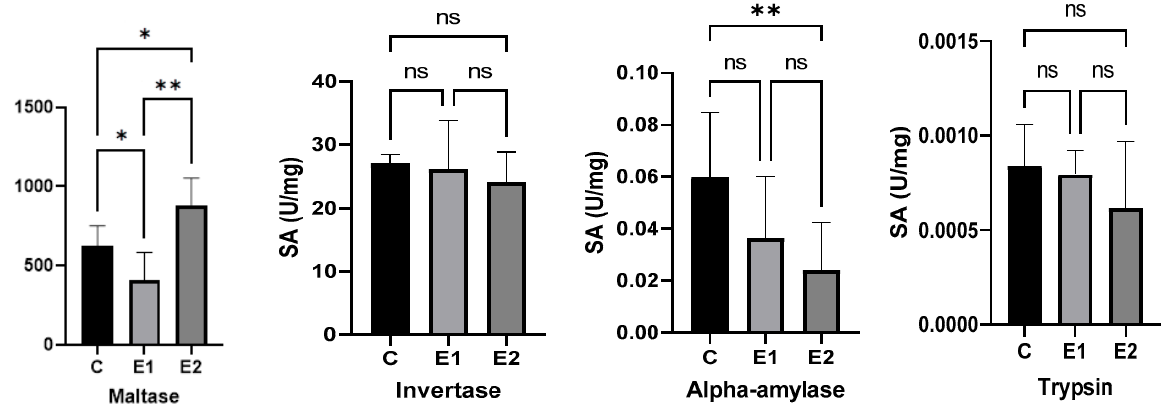
Figure 4. Effect of watermelon rind (E1) and sea buckthorn meal (E2) supplementation on the enzymatic specific activity (SA) of alpha-amylase and trypsin, expressed as U/mg protein, from the jejunum mucosa. Significant at * p ≤ 0.05; significant at ** p ≤ 0.01; ( n = 6); n: number of replicates; ns: none significant.